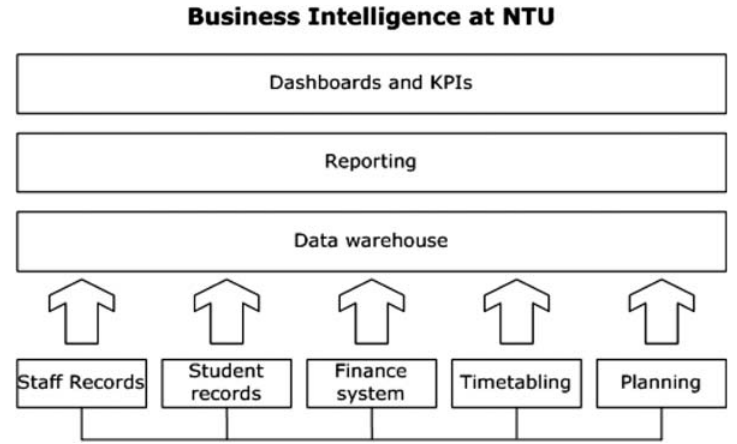
Figure 4. Business intelligence at